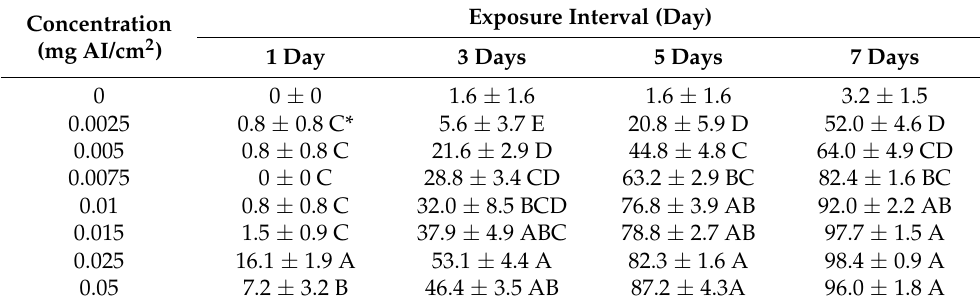
Table 4. Mean corrected mortality (% ± SE) of Acanthoscelides obtectus adults after 1-, 3-, 5- and 7-day exposure to ceramic floor tile surface treated with spinetoram at eight different concentrations. Exposure Interval (Day) Concentration (mg AI/cm 2 ) 1 Day 3 Days 5 Days 7 Days